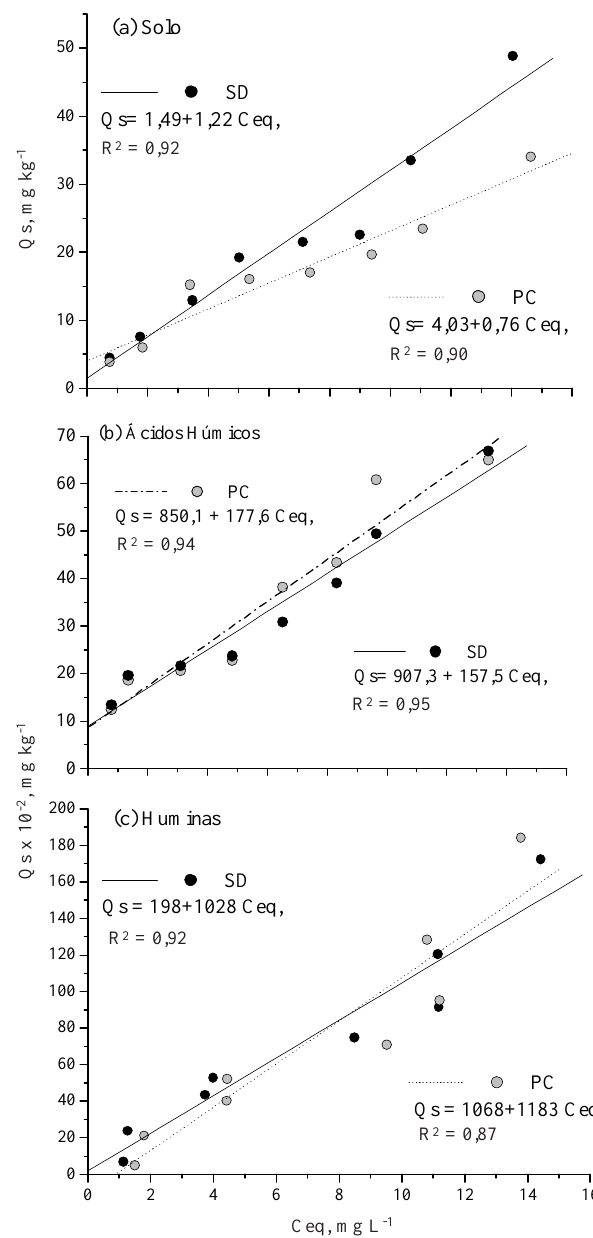
Figura 1. Relação entre concentração de equilíbrio (Ceq) e quantidade sorvida de acetochlor (Qs) em amostras de solo (a), de ácidos húmicos (b) e de huminas (c) de Argissolo Vermelho submetido à semeadura direta (SD) e ao preparo convencional